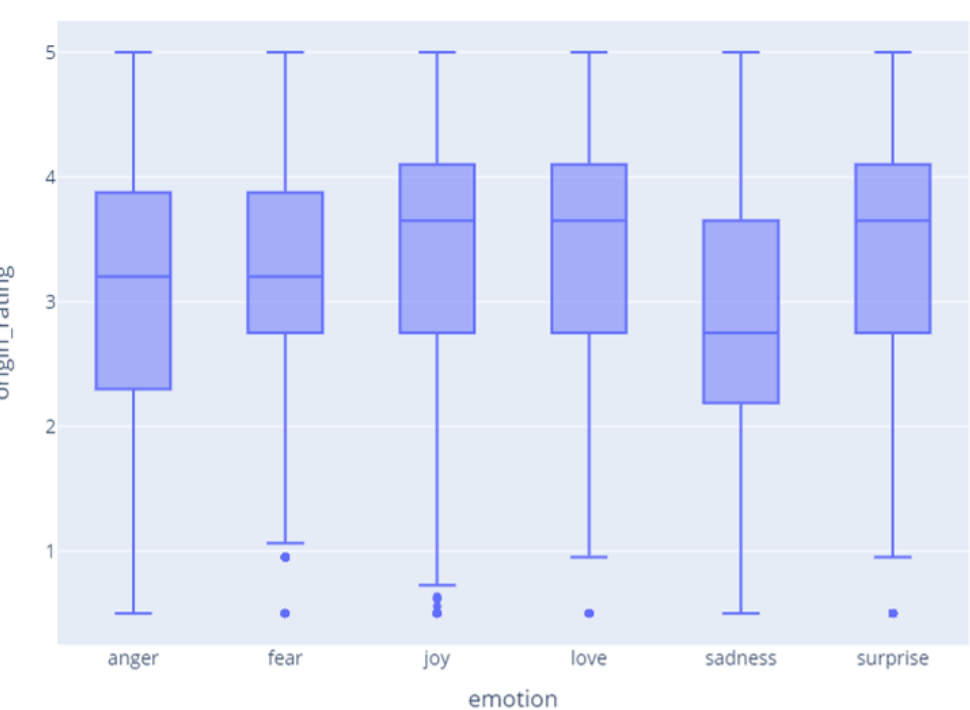
Figure 6. Relation between sentiment and rating.